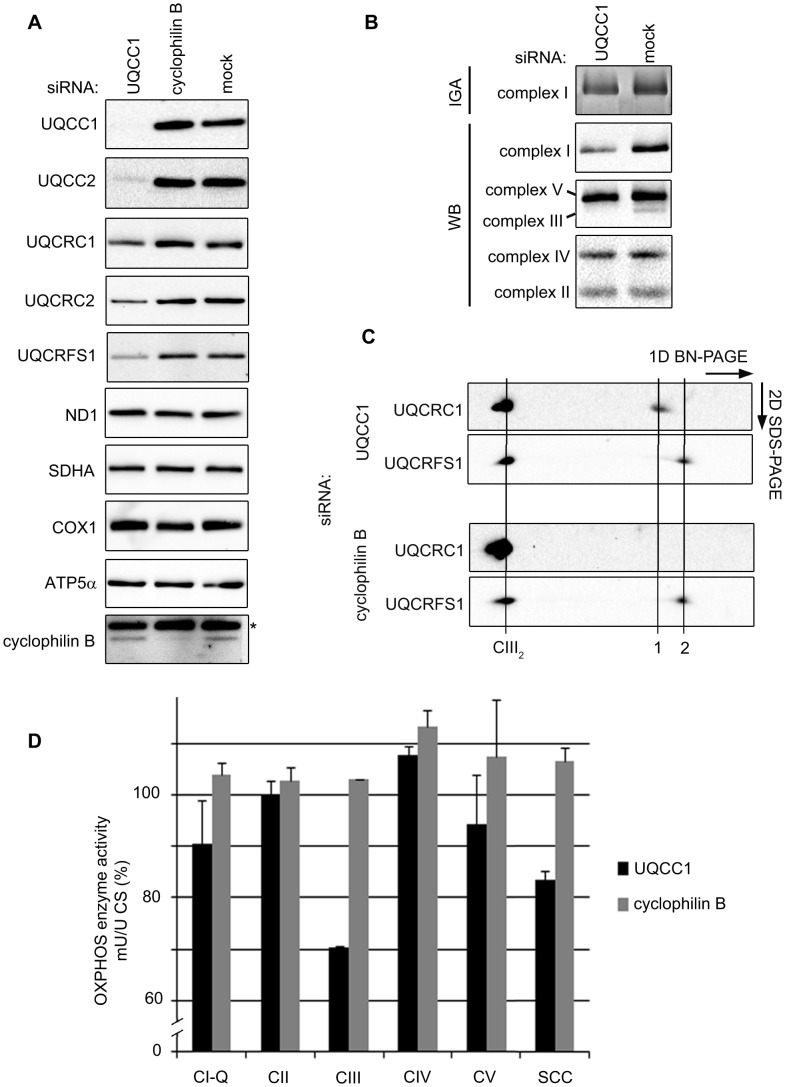
Depletion of the UQCC2 binding partner, UQCC1, affects complex III assembly.(A) SDS-PAGE and western blot analysis of mitochondrial extracts from HEK293 cells transfected with UQCC1 siRNA shows lower levels of complex III subunits UQCRFS1, UQCRC1 and UQCRC2. Subunits of complex I (ND1), complex II (SDHA), complex IV (COX1) and complex V (ATP5α) are not affected by UQCC1 knockdown. (B) BN-PAGE of HEK293 cells transfected with UQCC1 siRNA show reduced levels of holocomplex III (UQCRC2) and a mild effect on complex I in gel activity (IGA) and complex I holocomplex levels (NDUFA9). Levels of other OXPHOS complexes, complex II (SDHB), complex IV (COX2) and complex V (ATP5α) are not affected. Mock transfected cells were used as control). See Figure S7B-C for the quantification of the immunoreactive bands. (C) 2D BN-PAGE of HEK293 cells depleted of UQCC1 or cyclophilin B with indicated antibodies. The holocomplex III dimer is indicated with a line labeled CIII2. To the right are lower molecular weight subcomplexes: UQCRC1-containing subcomplex (1) and, likely, monomeric UQCRFS1 (2). Lauryl maltoside was used to solubilize OXPHOS complexes in parts B and C. (D) Respiratory chain enzyme activity measurements of HEK293 cells transfected with UQCC1 and cyclophilin B siRNAs. Mock transfected cells were set at 100%. Error bars indicate one standard deviation. Complex I ubiquinone reducing part (CI-Q), complexes II–V (CII-V) and combined activity of complex II and III (SCC) were measured relative to the activity of citrate synthase (CS).